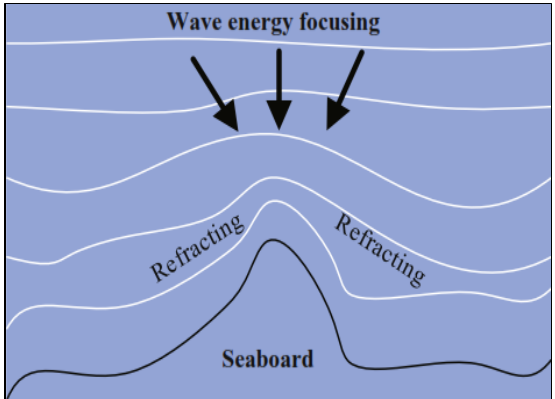
Figure 2. Concept of the wave refraction phenomenon and its relationship with the